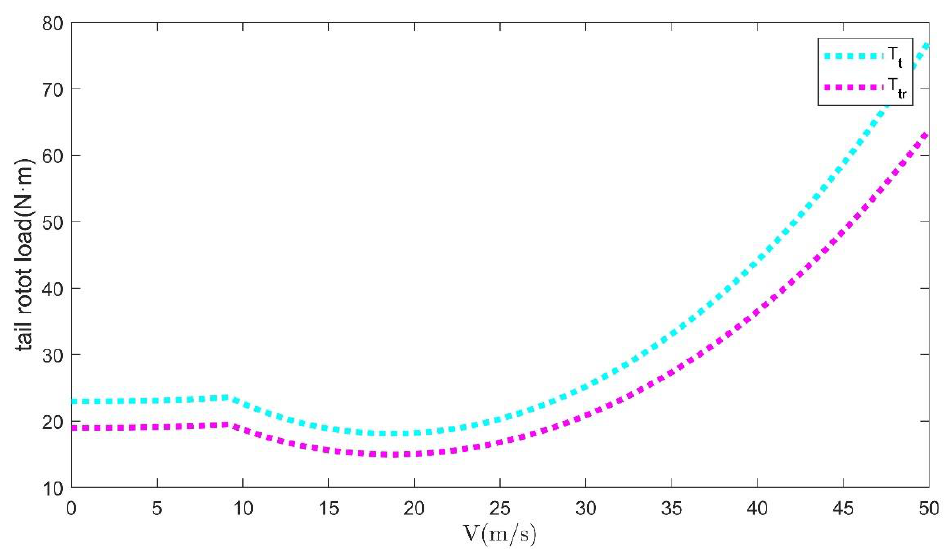
Figure 3. The tail rotor load varying with the helicopter horizontal forward speed.